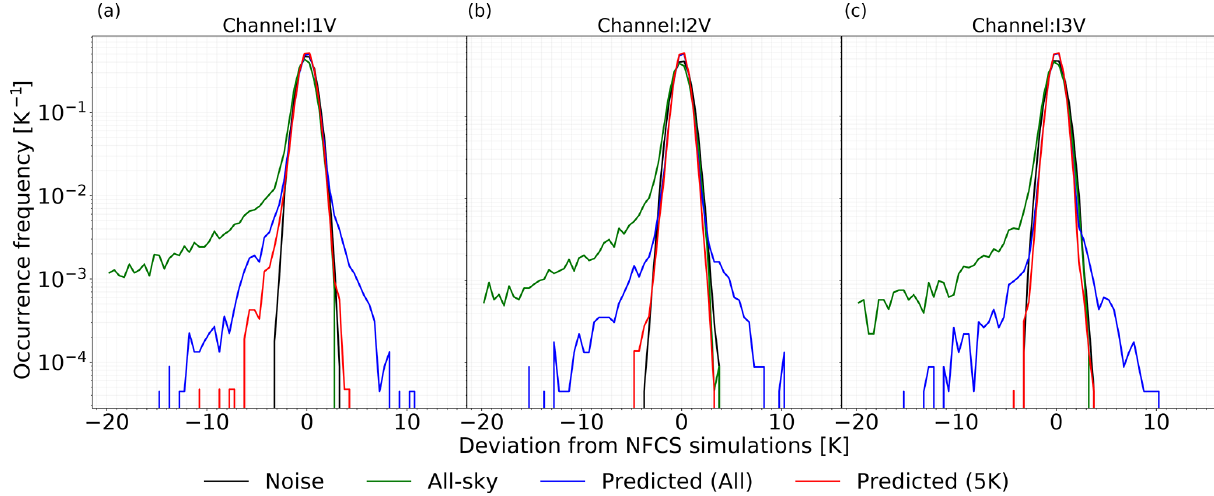
Figure 9. Same as Fig. 4 but from the QRNN-single experiment for ICI channels (a) I1V, (b) I2V and (c) I3V. Table 6. Same as Table 5 but from QRNN-single for ICI channels I1V, I2V and I3V. The fraction of rejected cases is given in parentheses. Simulations QRNN-single Clear-sky All-sky